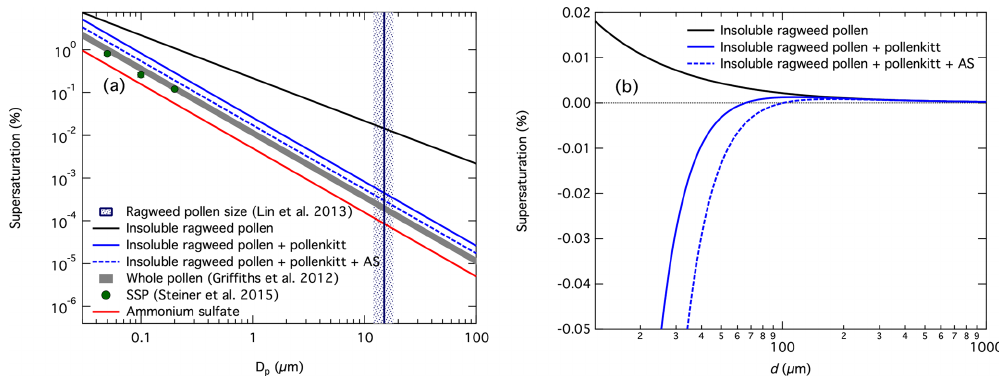
Figure 8. (a) Modeled CCN activity in terms of dry particle diameter ( D p ) vs. critical supersaturation (SS c ) for ragweed pollen whole grains or fragments with and without contributions from pollenkitt and ammonium sulfate. CCN activity derived from hygroscopicity values for pure ammonium sulfate and a range of values measured for different whole pollen grains by Griffiths et al. (2012), and for SSP measured by Steiner et al. (2015), are shown for comparison; (b) modeled Köhler growth curves for an initially dry 15µm ragweed pollen grain (indicated as vertical line in (a) ) with the corresponding contributions from pollenkitt (15% mass fraction) and ammonium sulfate (in 1 : 4 mass ratio relative to